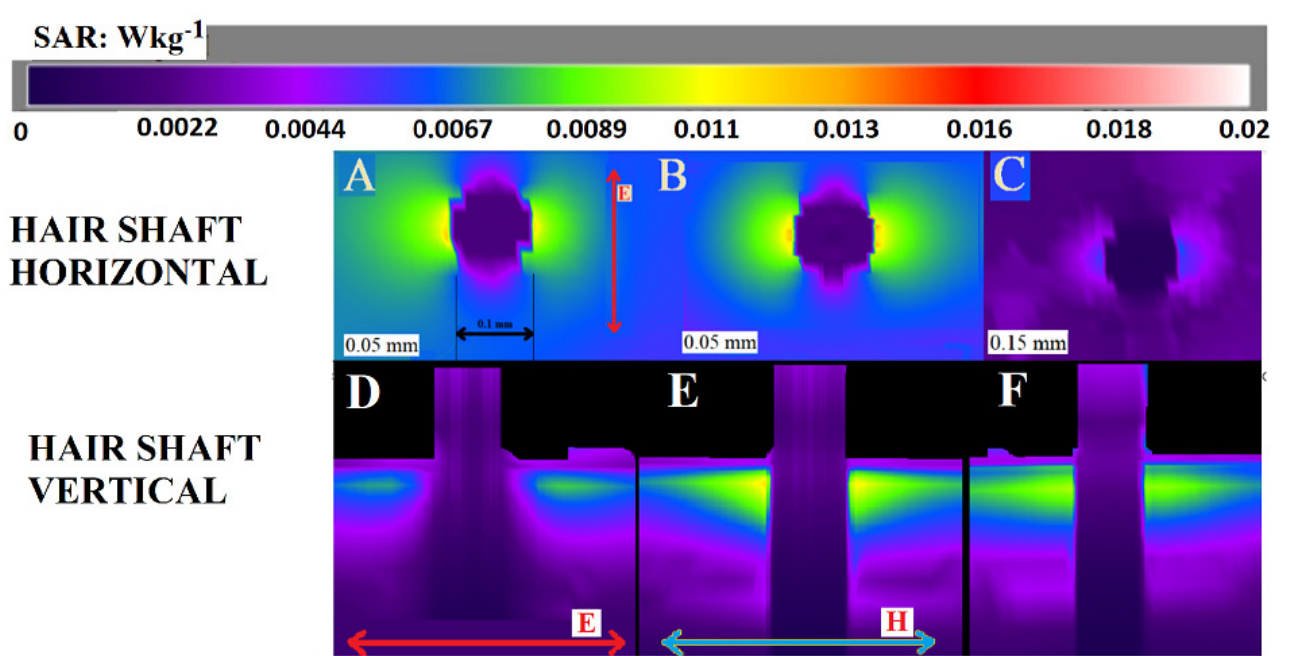
Figure 3. SAR distribution, θ i = 0 ◦ (orthogonal to the skin), anatomically correct hair radius of 0.05 mm. ( A ) Horizontal cross-section, simple hair shaft, direction of E-field is shown ( B ) Complex hair shaft. ( C ) Simple hair at a depth of 0.15 mm (in the Stratum Basale). ( D ) Vertical cross-section, complex hair shaft, direction of E-field is shown. ( E ) Complex hair shaft, direction of H-field is shown (at right angles from ( D )). ( F ) Simple hair, H-field as shown in ( E ). The simulation results for the 30 ◦ and 60 ◦ angled excitations are shown in Figure 4. The SAR at a horizontal cutplane at 0.05 mm, complex hair, with θ i = 30 ◦ , is demonstrated in Figure 4A. The excitation is from left, and the direction of the E-field is shown. A three- dimensional image, with a cutplane at 0.047 mm, is presented in Figure 4B. Figure 4C,D, demonstrate the time-domain images of the PD change in the lateral cutplane at θ i = 30 ◦ . The time-domain PD change horizontal cutplane at 0.05 mm, at θ i = 30 ◦ and 60 ◦ , is shown in Figure 4E–G and Figure 4H – J, respectively. To improve contrast, the PD in the values for the θ i = 30 ◦ figures are presented over the range of 0–0.004 Wm − 2 and for θ i = 60 ◦ , the range is 0–0.002 Wm − 2